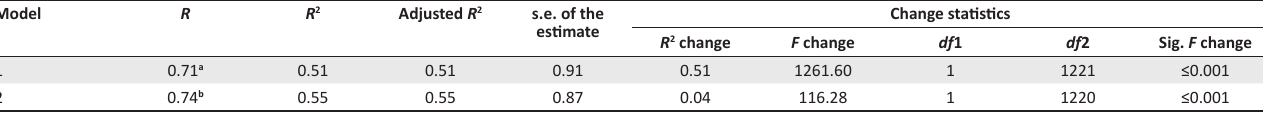
TABLE 3: Results of stepwise multiple regression analysis − model summary with supervisory trust as dependent variable and the ethical leadership and P-O fit constructs as independent variables.